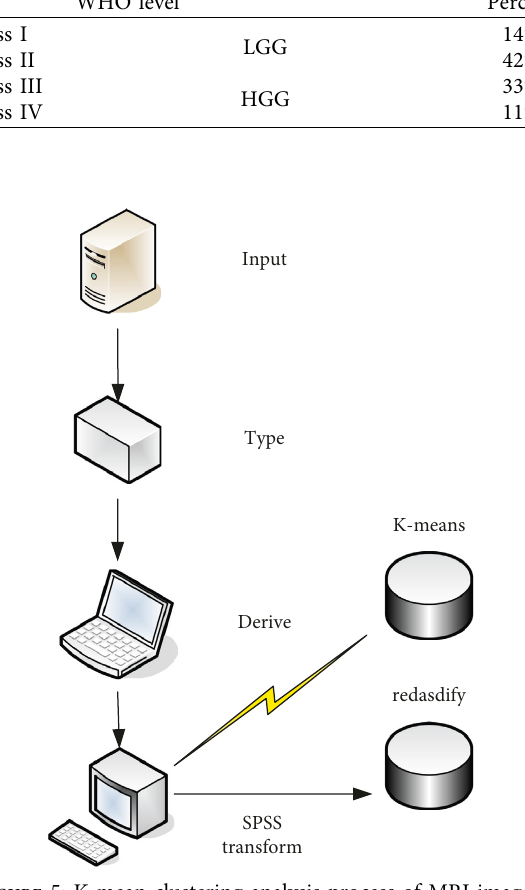
Figure 5: K-mean clustering analysis process of MRI